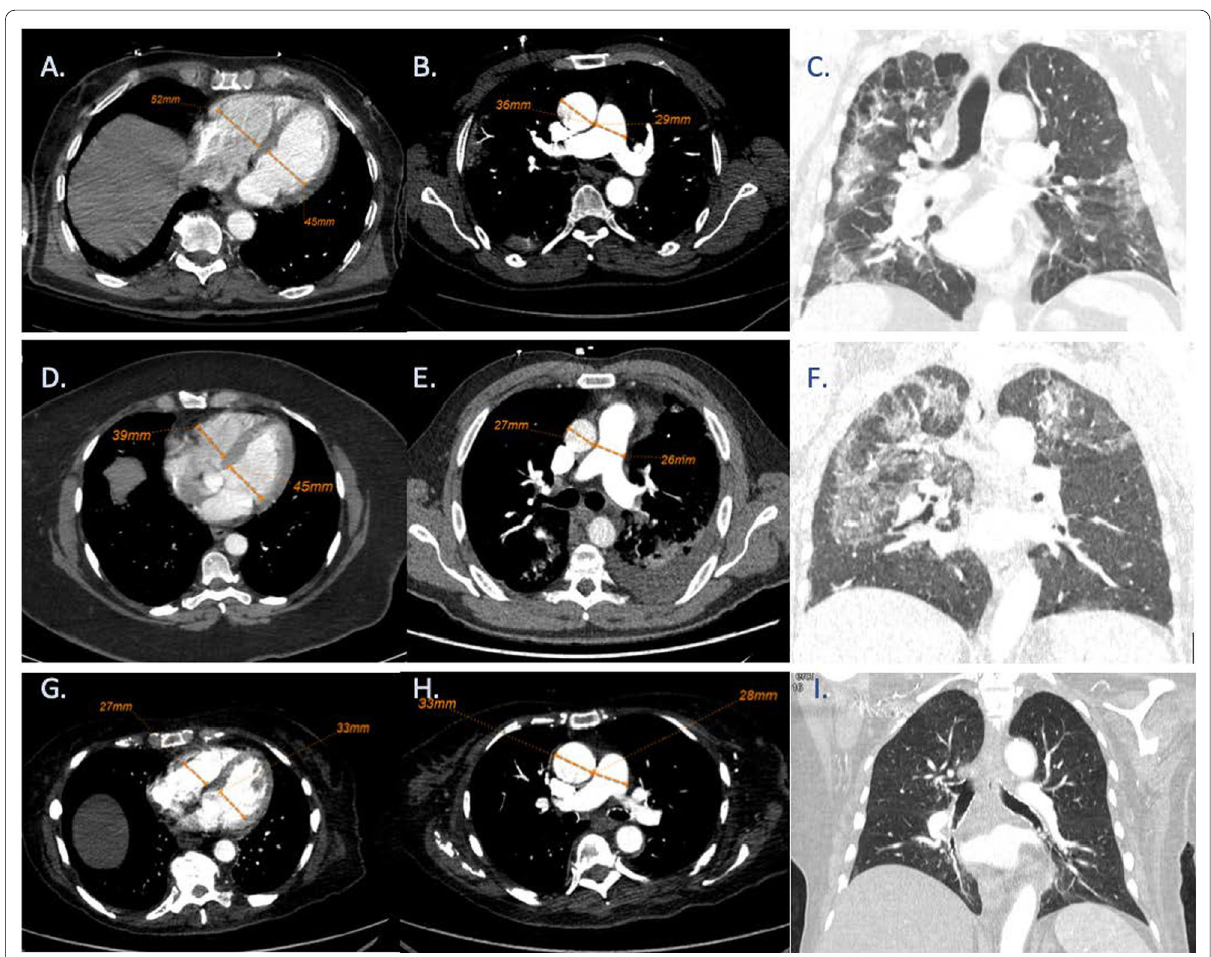
Fig. 1 Representative images of quantitative measurements and lung parenchyma in COVID-19, Org-PNA, and normal control cohort. A – C COVID-19 (RV 52 mm, LV 45 mm, RV:LV 1.15, PA 29 mm, AO 36 mm, PA:AO 0.8). D – F Org-PNA (RV 39 mm, LV 45 mm, RV:LV 0.86, PA 26 mm, AO 27 mm, PA:AO 0.96). G – I Normal (RV 27 mm, LV 33 mm, RV:LV 0.81, PA 28 mm, AO 33 mm, PA:AO 0.84). COVID-19 novel coronavirus, RV right ventricle, LV left ventricle, AO aorta, PA pulmonary artery, Org-PNA organizing